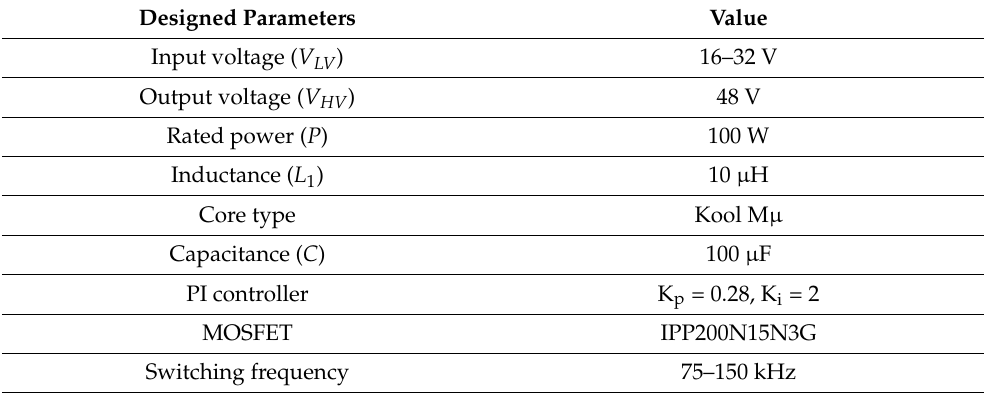
Table 1. Parameters of the experimental prototype and simulation.